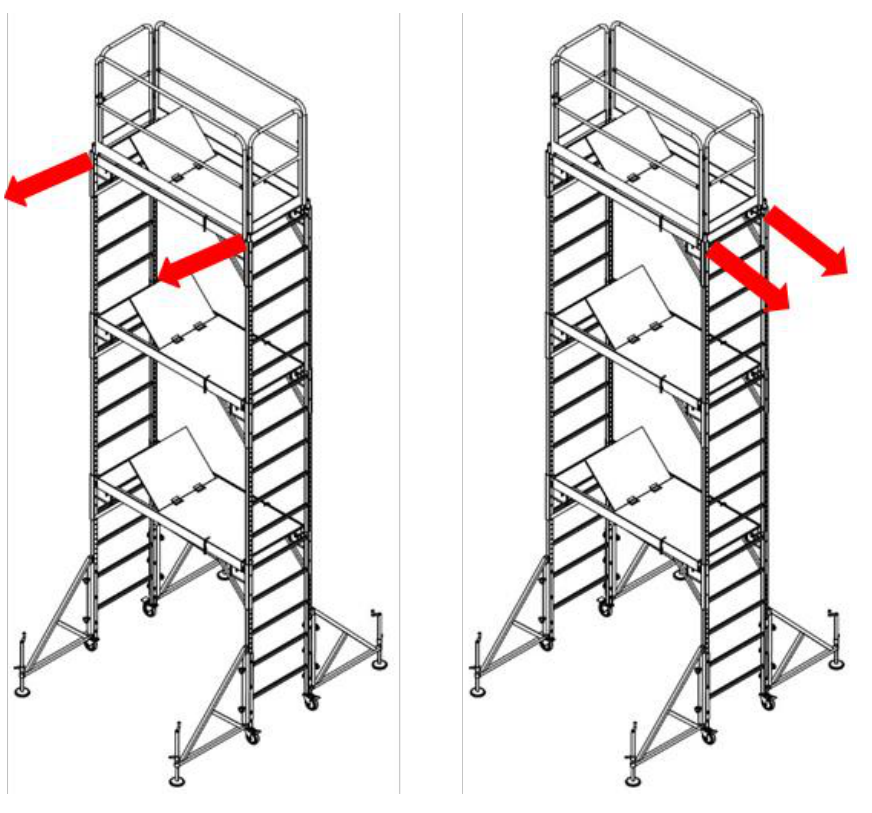
Figure 8. Horizontal load test method.